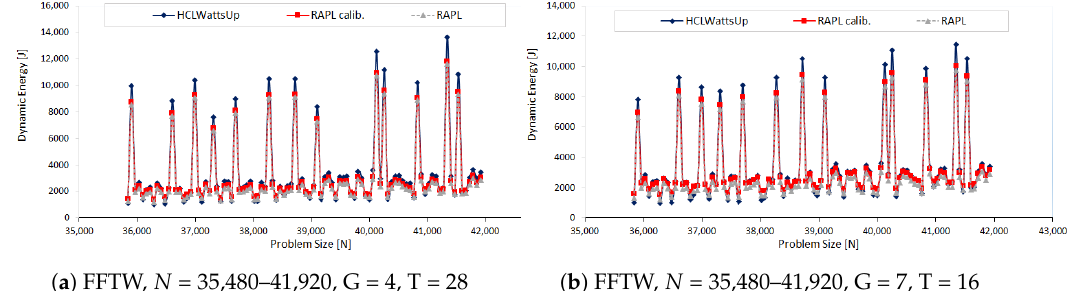
Figure A2. Dynamic energy profiles by RAPL and HCLWattsUp on HCLServer03 falling into Class B. G = Threadgroups and T = Threads.